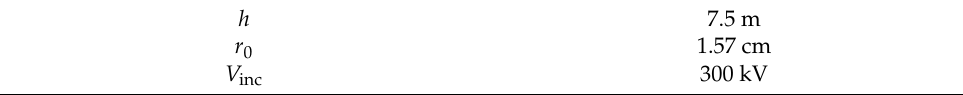
Table 6. Parameters of the reference configuration in the inset of Figure